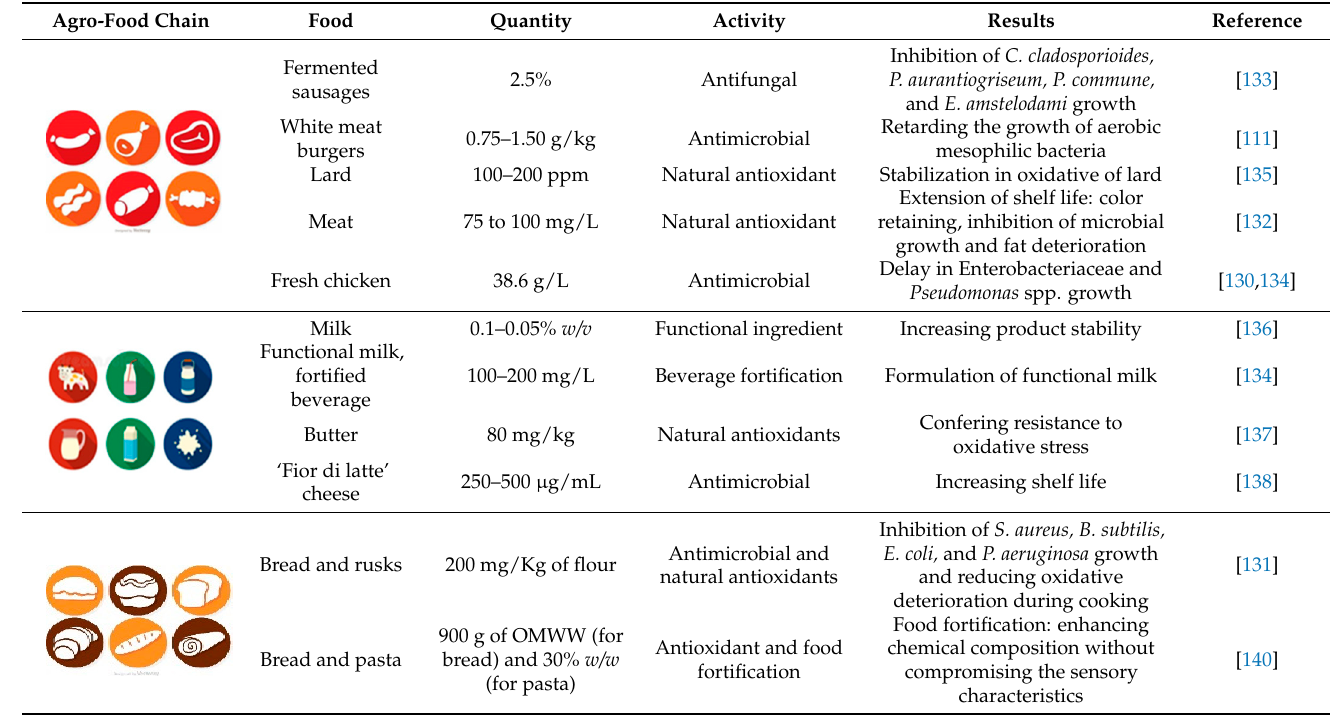
Table 2. Application of OMWW in agro-food chains.